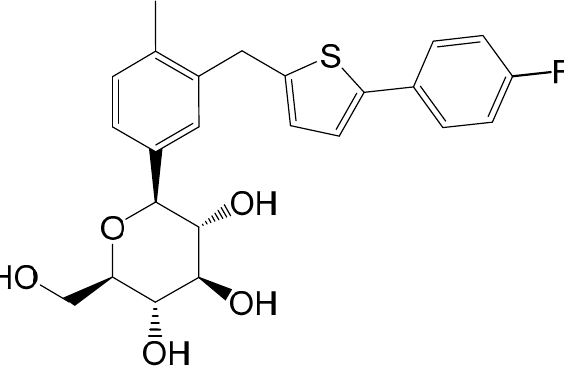
Figure 10. Chemical structure of CG. The chemical name of CG was (1 S )-1,5-anhydro-1-[3-[[5-(4-fluorophenyl)-2-thienyl]methyl]-4-methylphenyl]- D -glucitol.